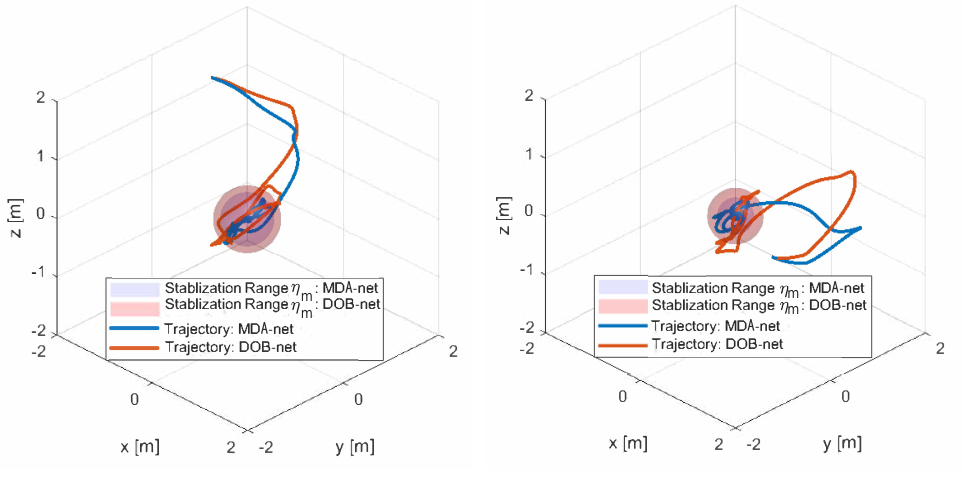
Figure 6. Examples of the trajectories obtained by MDA–net and DOB–net, respectively. ( a ) The stabilization range eta m obtained from MDA–net is 0.43 (m) and eta m obtained from DOB–net is 0.54 (m); ( b ) The stabilization range eta m obtained from MDA–net is 0.22 (m), and eta m obtained from DOB–net is 0.45 (m).